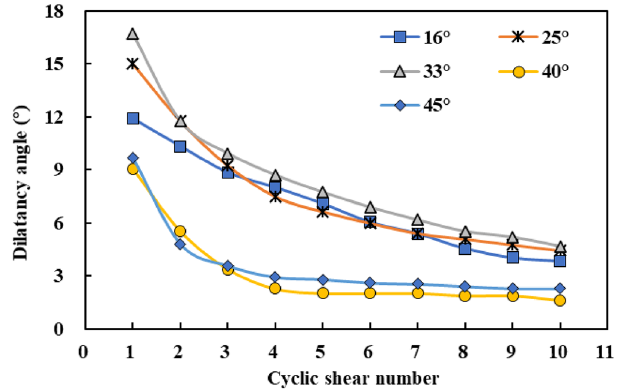
Figure 5. Dilatancy angle changes with shear cycles under different initial undulation